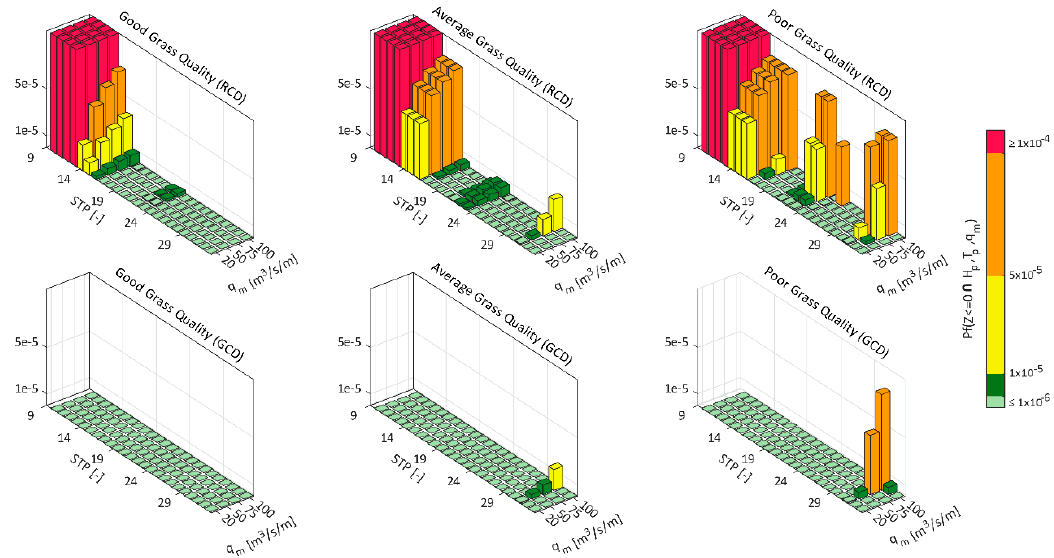
Figure 14. Failure probabilities per storm at each STP for different grass qualities for the RCD (upper three bar plots) and for the GCD (lower three bar plots). Bars in read coincide with locations in failure state before the storm condition was routed.